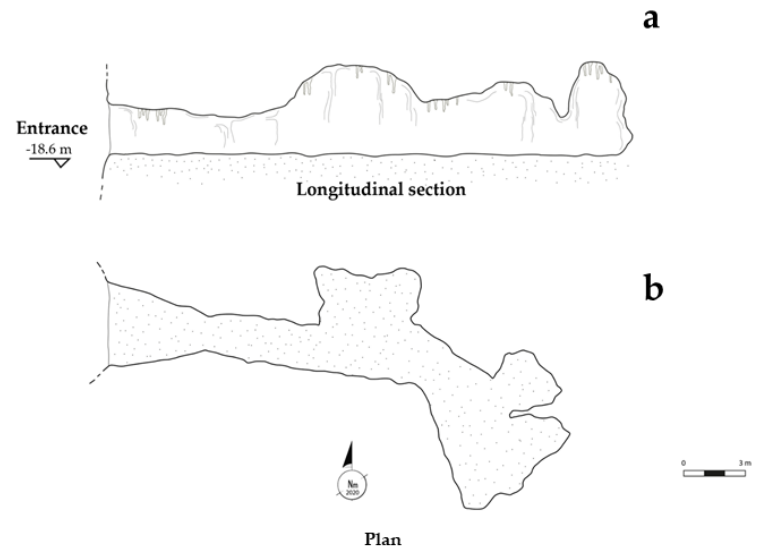
Figure 3. Longitudinal vertical section ( a ) and plan ( b ) of the Elle